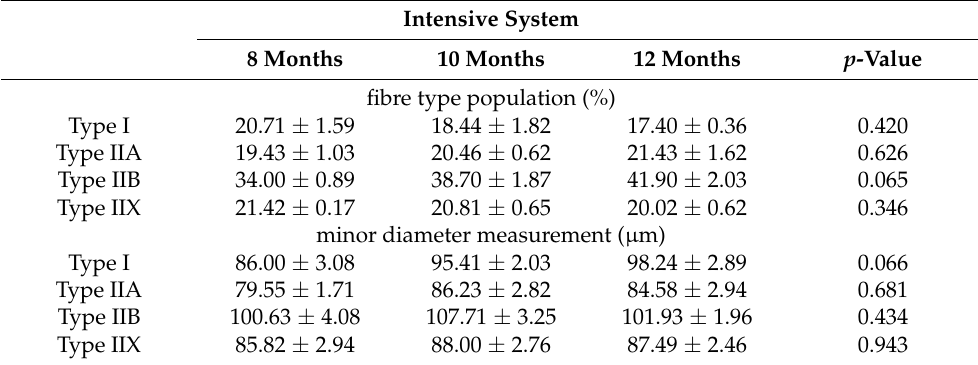
Table 3. Muscle fibre population and size of m. Longissimus thoracis from Iberian × Duroc crossed animals reared under the intensive system according to slaughter